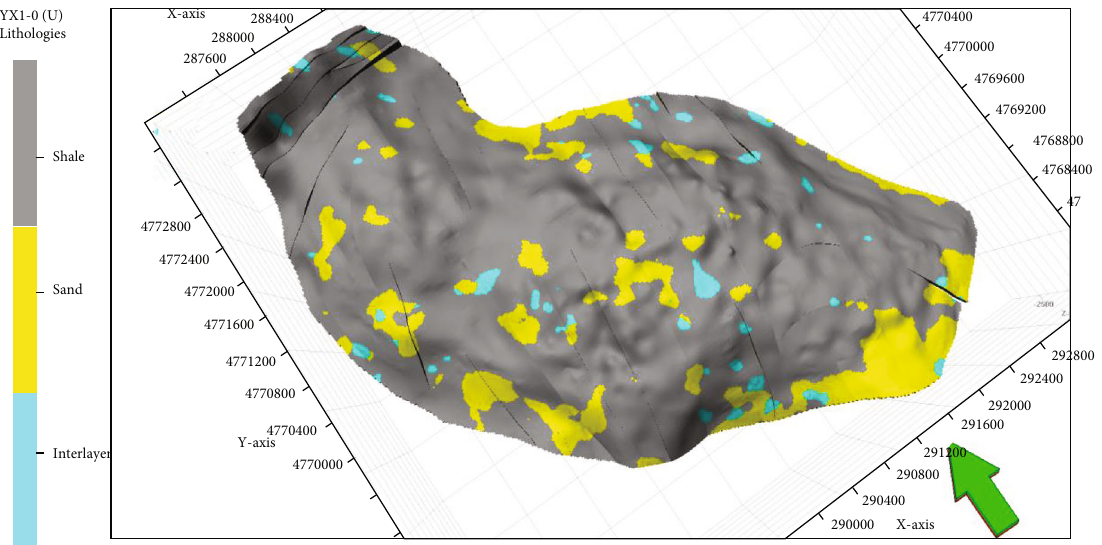
Figure 14: Lithofacies model of s 3